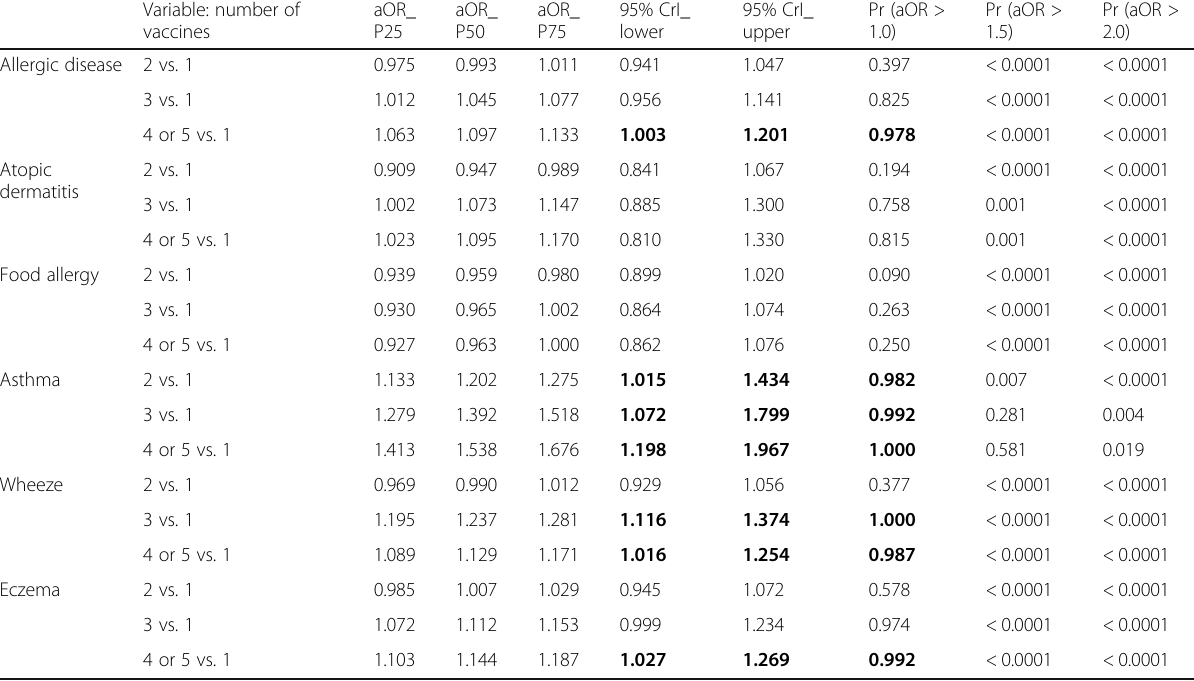
Table 4 Results of Bayesian multivariable logistic regression for allergic features associated with number of initial inactivated vaccines for complete cases (RQ2)